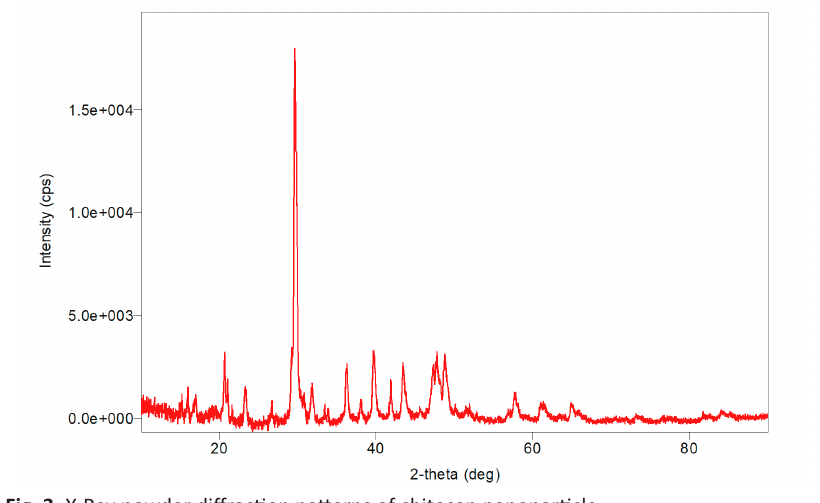
Fig. 3. X-Ray powder diffraction patterns of chitosan nanoparticle.